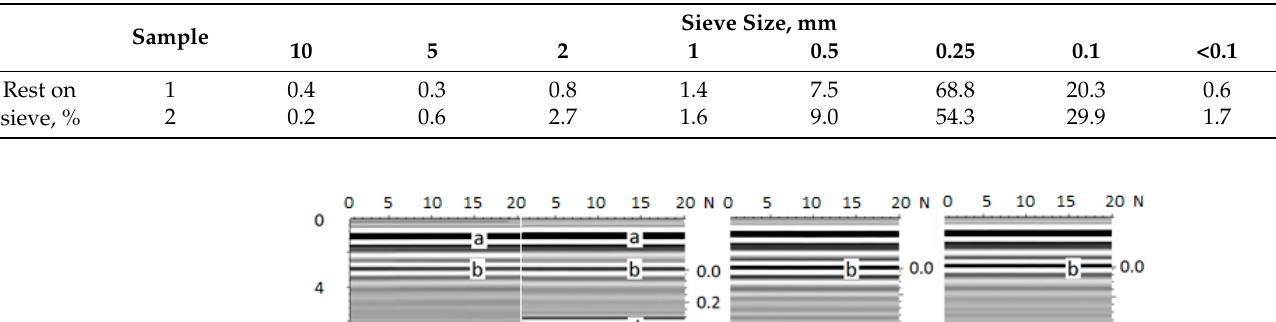
Table 2. Granulometric composition of sands (determined according to ASTM D6913/D6913M-17).